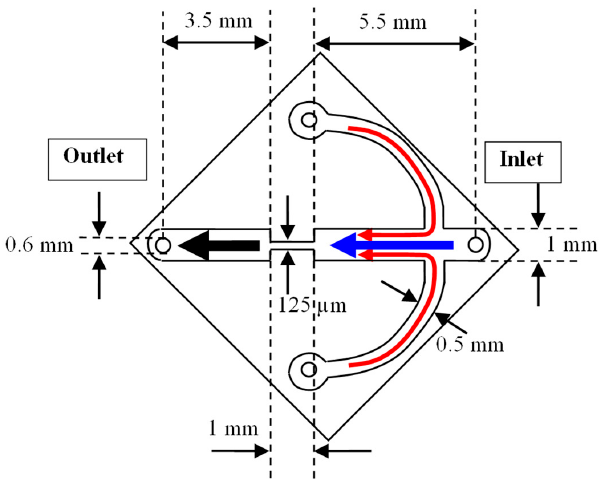
Figure 1. Schematic 2-D diagram of the micro-channel. Arrows depict the flow of the center-stream (blue) and side-stream (red) liquids respectively.